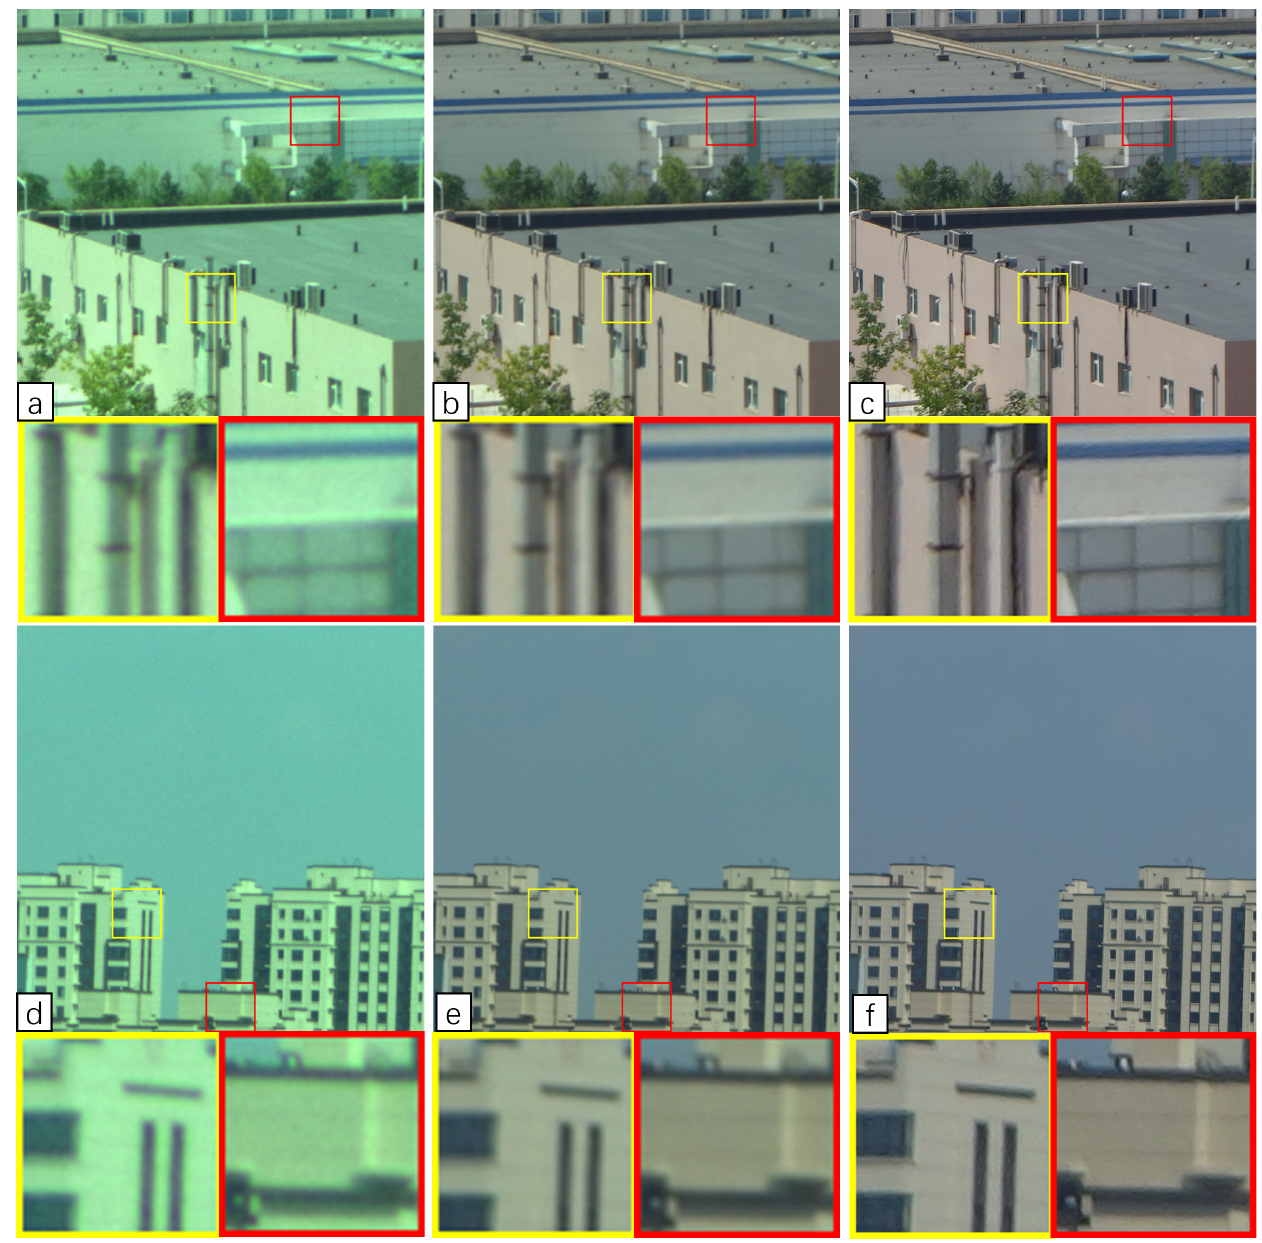
Figure 6. SHDCIS outdoor imaging experiment; ( a , d ) are the raw images captured by the detectors taken outdoors by SHDCIS; ( b , e ) are the processed results using the convolutional neural network proposed in [10]; ( c , f ) are the reconstructed images calculated by the DDZMR network